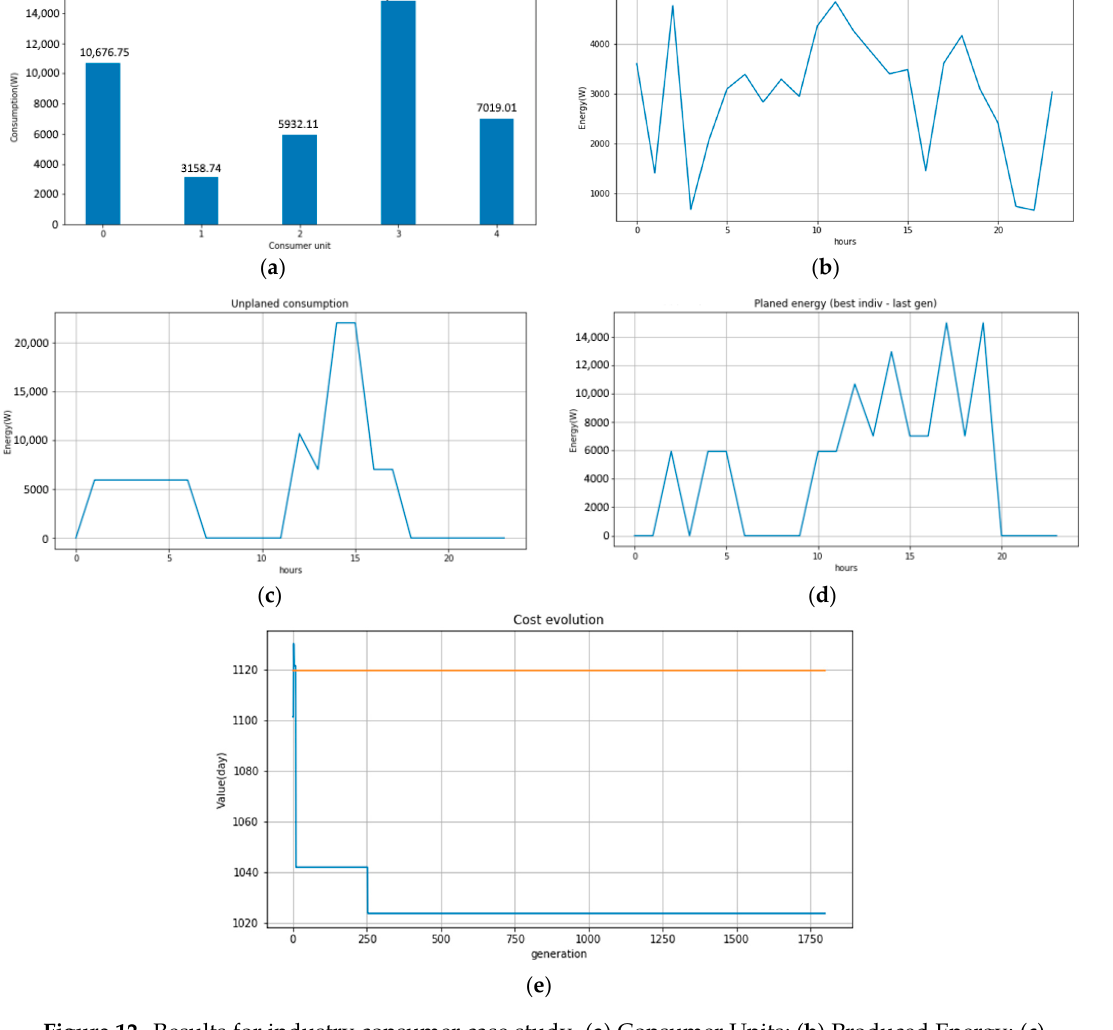
Figure 12. Results for industry consumer case study. ( a ) Consumer Units; ( b ) Produced Energy; ( c ) Unplaned Consumption; ( d ) Planed Energy; ( e ) Cost Evolution.